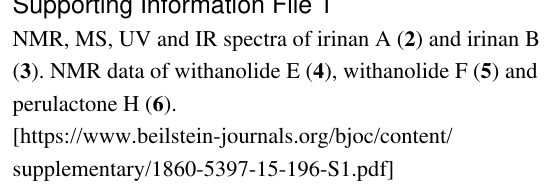
Table 1; HRESIMS m / z : [M + Na] + calcd for C 19 H 24 O 3 Na + , 323.1618; found,